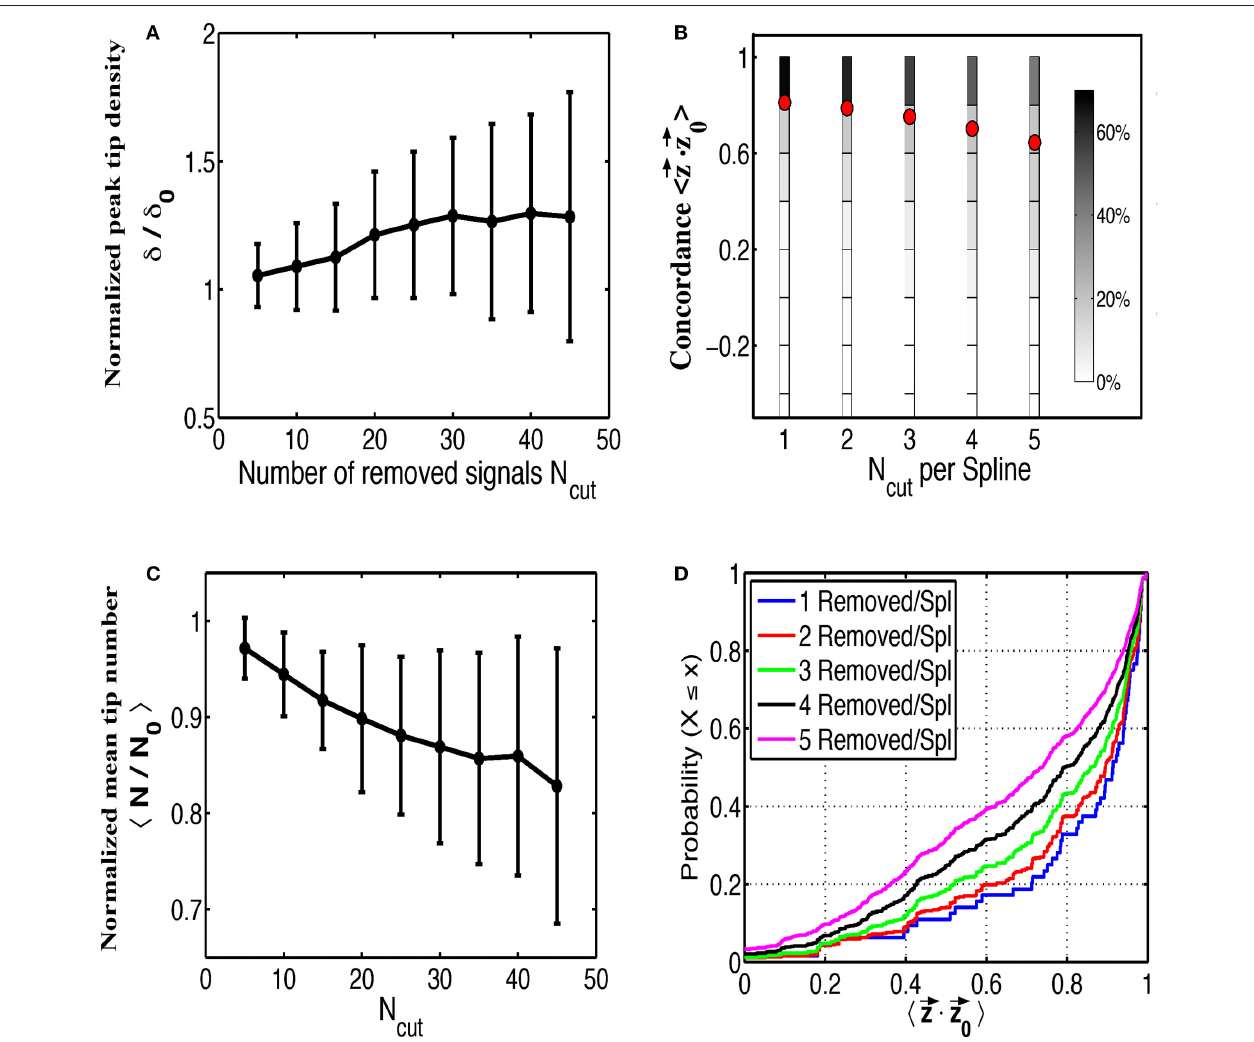
FIGURE 3 | The effects of random removal of electrodes. Normalized plots of peak tip density around the site of termination (A) , and mean number of tips (B) , as a function of the number of electrodes removed are shown for 200 trials. Error bars show standard deviation. Electrodes are then systematically removed per spline and ⇀ ⇀ z and the original phase vectors z 0 is shown as multiple histograms in (C) , with red dots marking the the concordance between the interpolated phase vectors mean, and as cumulative distribution functions in (D)